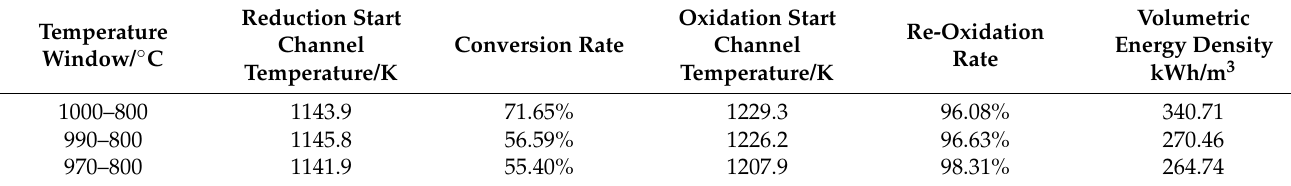
Table 3. Reaction processes within different temperature windows.